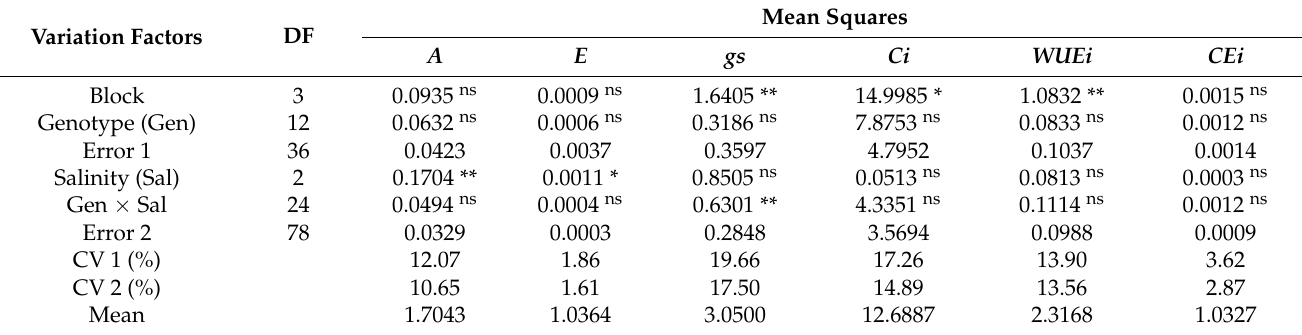
Table 9. Summary of analysis of variance of gas exchange—assimilation rate ( A ) ( µ mol m − 2 s − 1 ), tran-